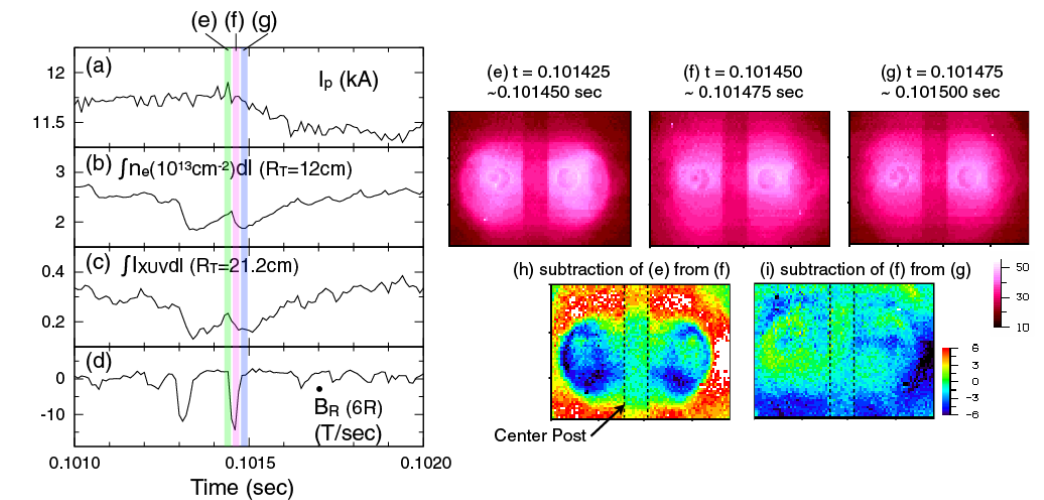
Figure 5. Plasma ejections across the LCFS are observed when Ip exceeds 10 kA. Time traces of (a) the plasma current, (b) horizontal chord line-integrated density, (c) XUV intensity (Rt = 21.2 cm) and (d) dBr/dt measuread by the magnetic on Port 6R. (e)-(g) Visible camera images and (h)-(i) differences between two consecutive